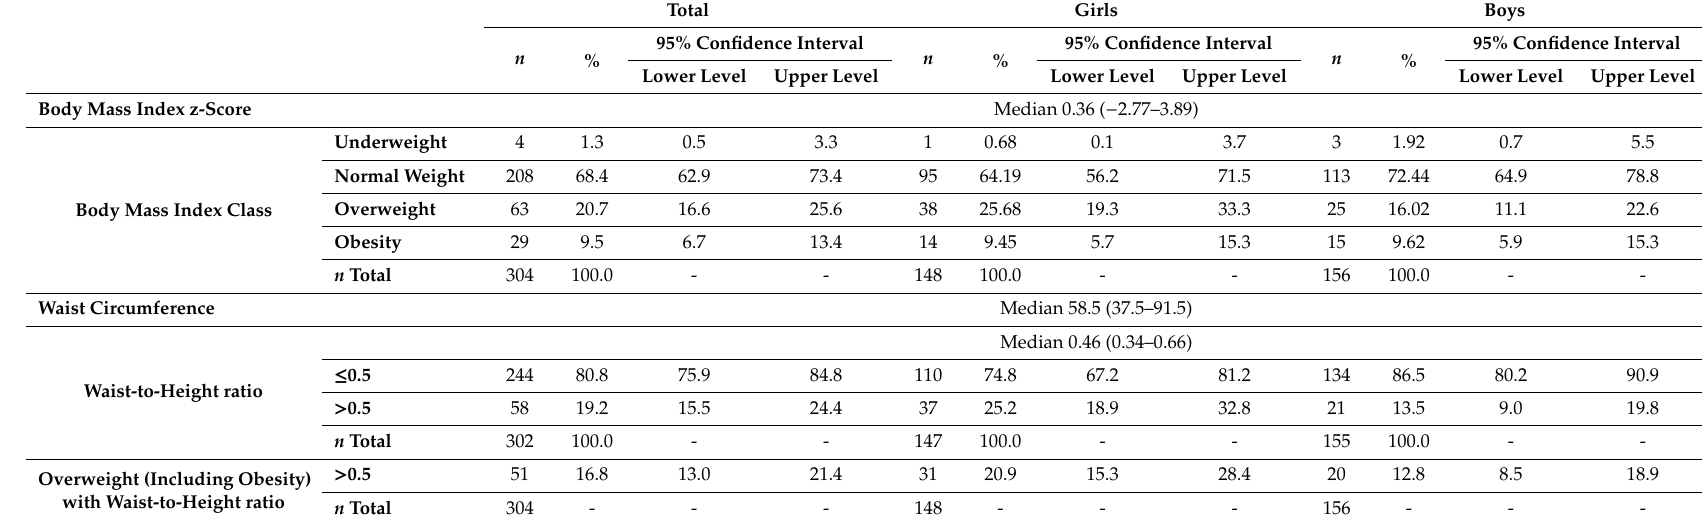
Table 2. Characterization of anthropometric measurements and calculated